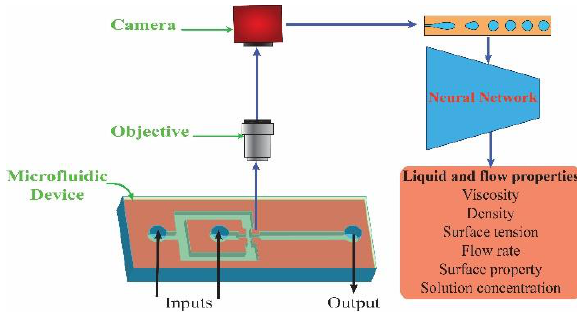
Fig. 1. Images of droplet formation in a microfluidic channel are used to train a neural network to extract information about the liquid and flow properties.